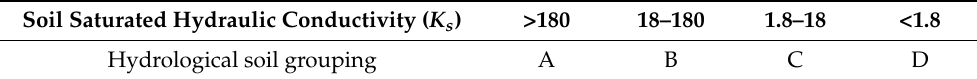
Table 2. Classification standard for hydrological soil grouping.